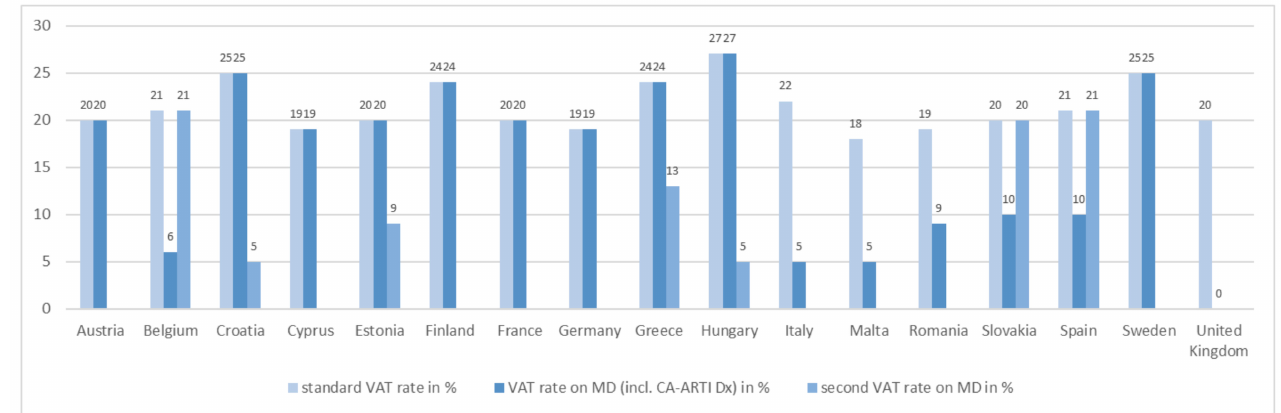
Figure 3. VAT rates for CA-ARTI diagnostics. CA-ARTI: community-acquired acute respiratory tract